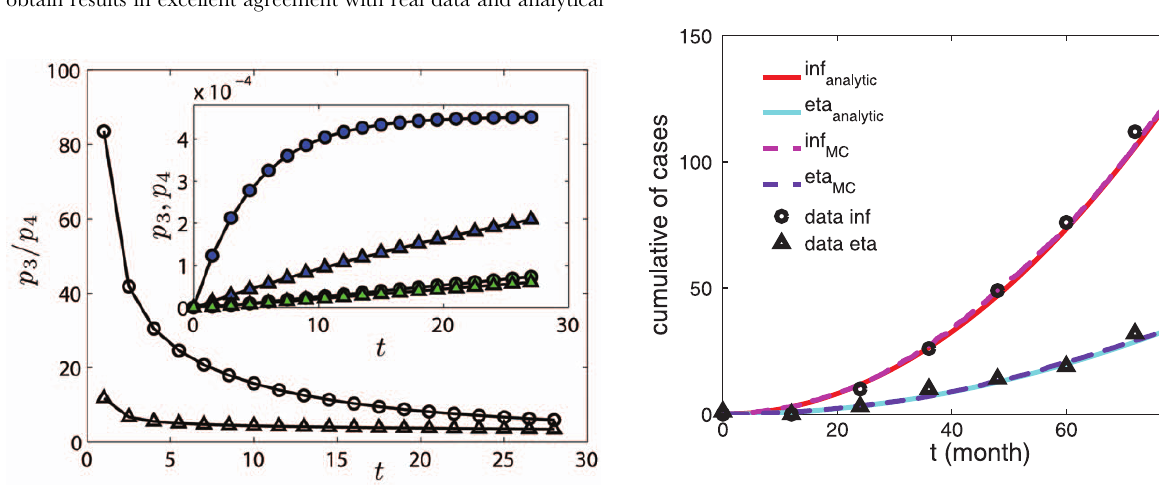
and this form successfully fits experimental data, as shown in Figure 6; the best-fit coefficients are reported in Table 2, and the related errors are shown in Figure 7.